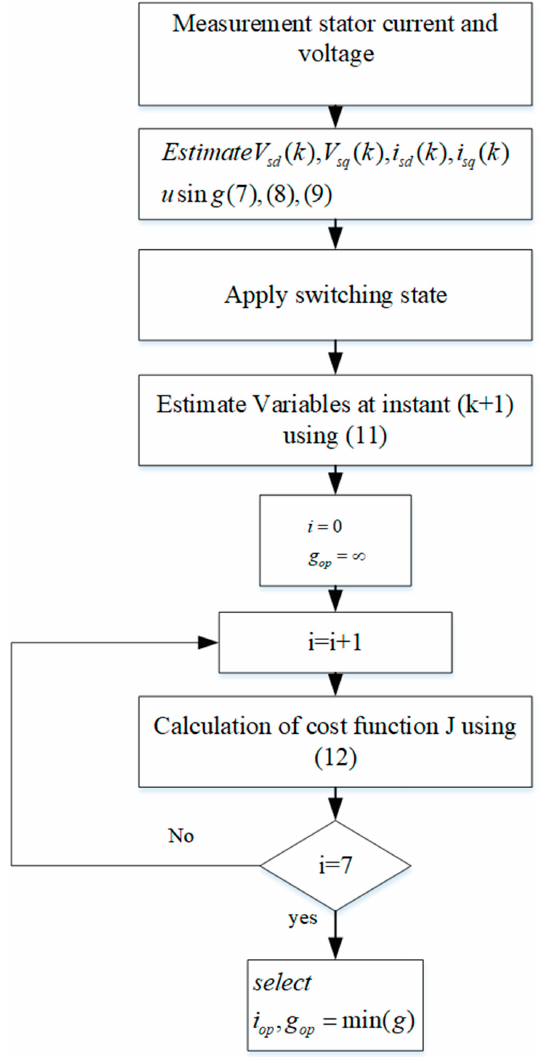
Figure 5. Flow chart of a conventional FCS-MPC system.